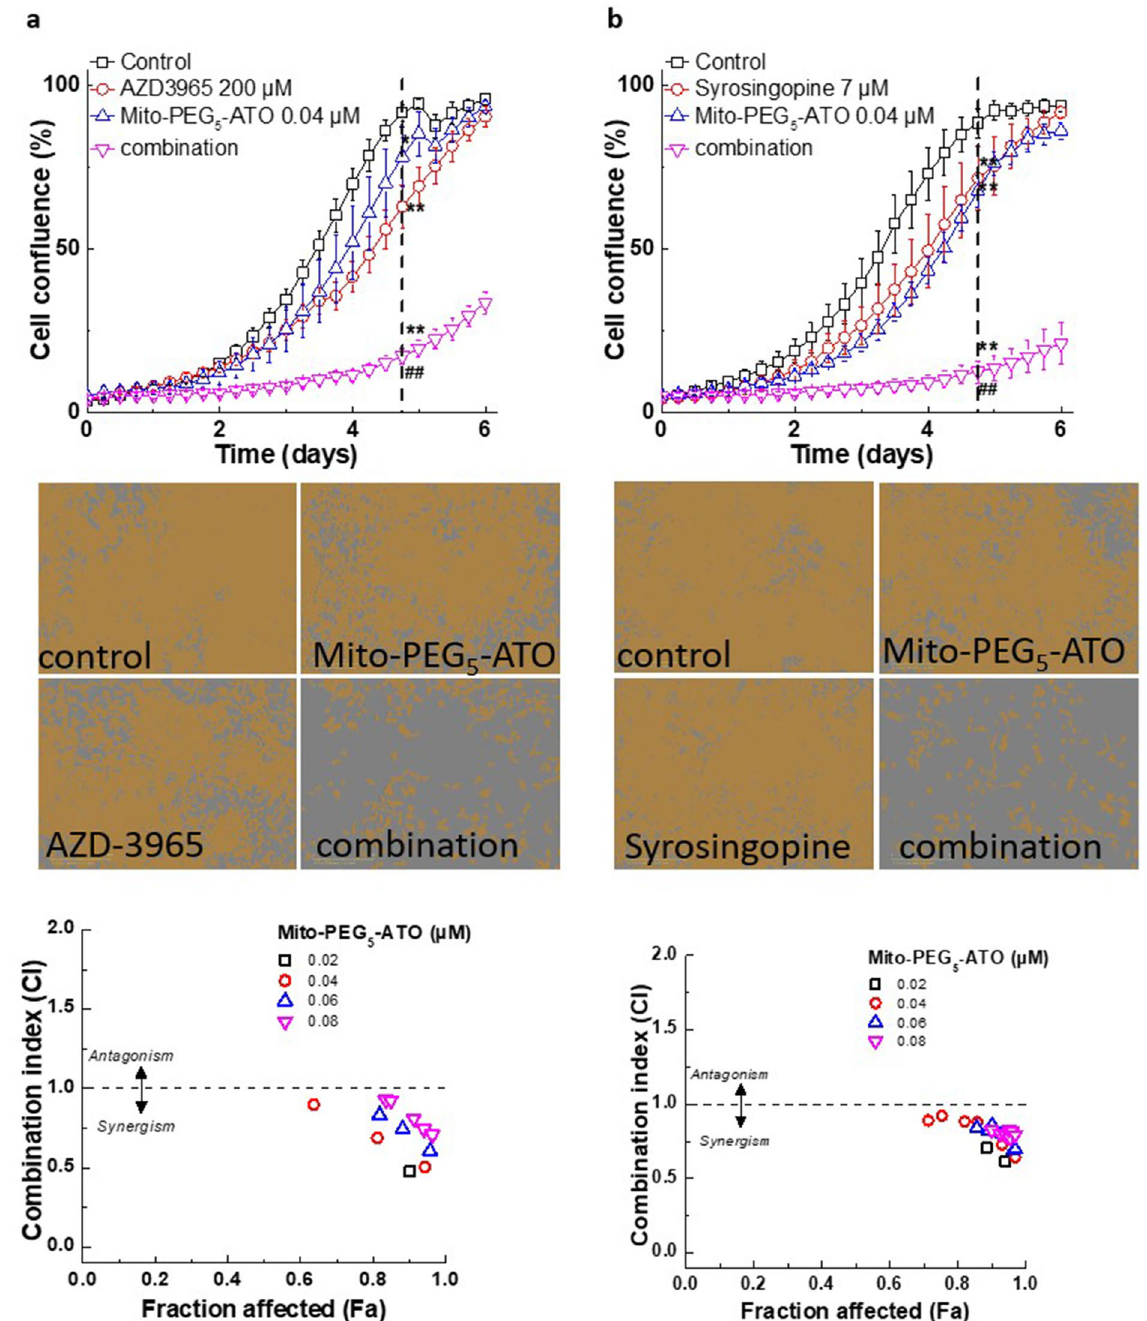
Figure 5. Synergistic inhibition of cell proliferation by Mito-PEG 5 -ATO and AZD-3965 or syrosingopine in human pancreatic cancer (MiaPaCa-2) cells. (Top) MiaPaCa-2 cells were treated with Mito-PEG 5 -ATO and AZD-3965 ( a ) or syrosingopine ( b ) independently and together at the indicated concentrations, and cell growth was monitored continuously. Data shown are the mean ± SD (n = 5). (Middle) Representative cell images are shown as a segmentation mask illustrated in brown when control cells reached ~ 90% confluence (vertical dashed line). ** p < 0.01 vs control. ## p < 0.01 vs Mito-PEG 5 -ATO or AZD-3965 alone. (Bottom) Cell confluence (control cells reached ~ 90% confluence) is plotted against concentration for the synergistic calculation. Bottom panels (a, AZD-3965; b, syrosingopine) show the combination index–fraction affected plots. The fraction affected parameter is used as a measure of the efficiency of the drug(s), with a value of 0 indicating complete inhibition of cell confluence and a value of 1 indicating the lack of effect on cell confluence. Data shown are the mean ±